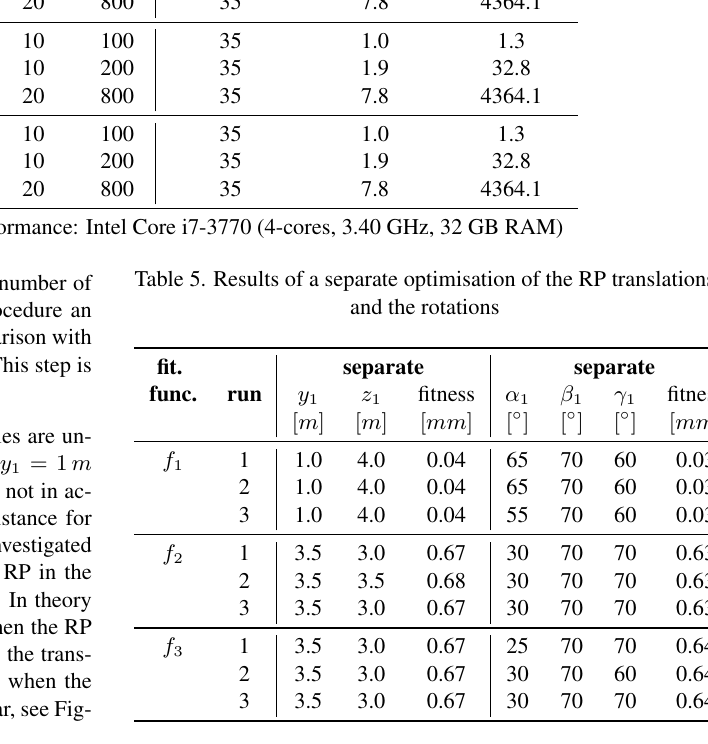
Table 4. Different executed test scenarios